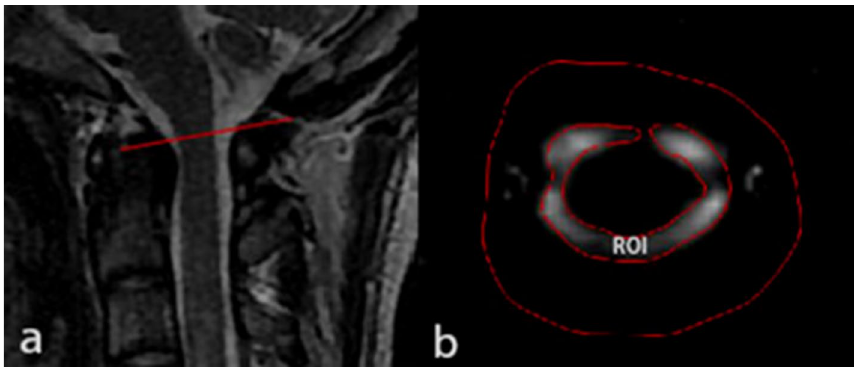
Figure 1. Example of MR images from one of the volunteers. The region of interest is the entire cross-sectional area of the subarachnoid space at the level of the upper border of atlas. ( a ) Showing the level of upper border of the atlas (red line) in the median sagittal plane of nape; ( b ) the region of interesting (ROI, inner closed irregular contour) showing the entire cross-sectional area of the subarachnoid space in the transverse plane at the level of the upper border of atlas. And the outer red line serves as a